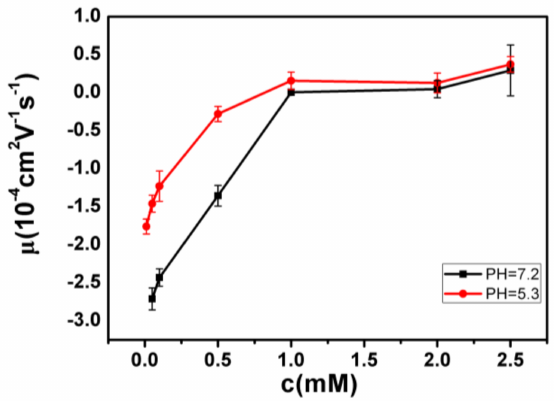
Figure 3. Electrophoretic mobility of DNA as a function of the concentration of different La 3+